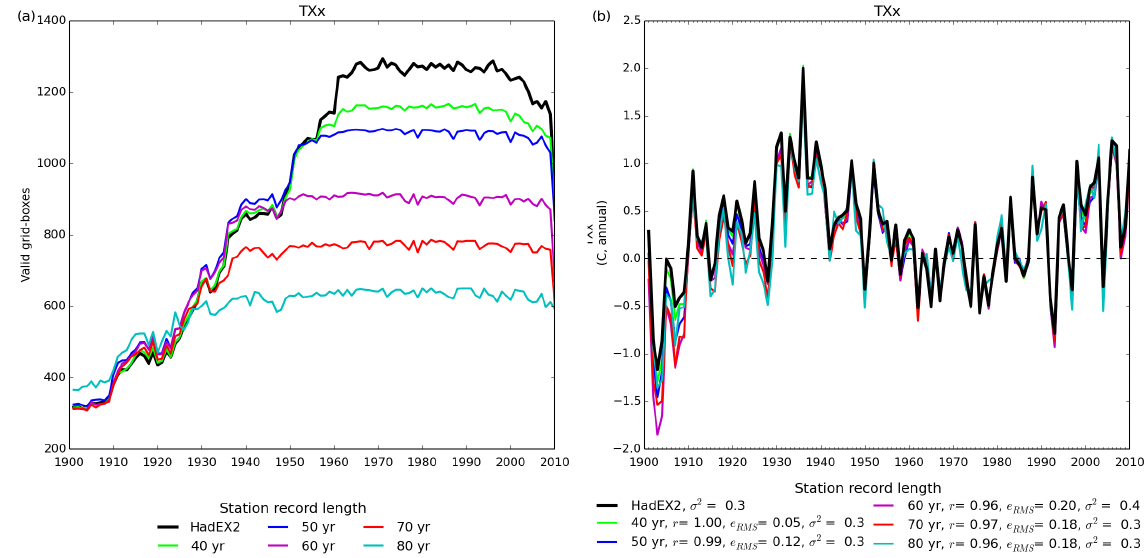
Figure 9. (a) The number of non-missing grid boxes and (b) the time series for global average TXx (maximum T max ) for the different station